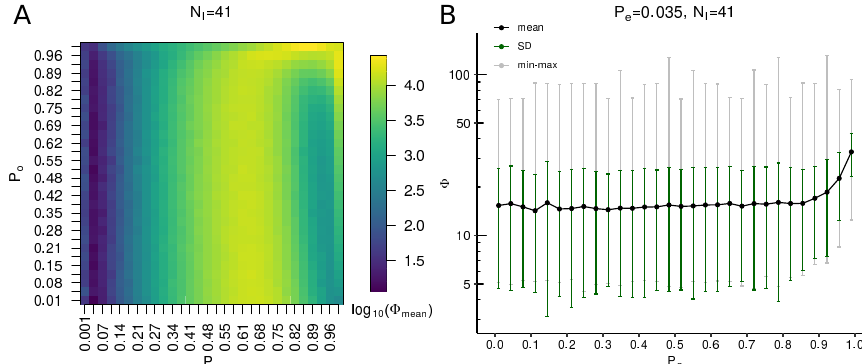
Figure 10. The landscape of topological fitness of rule-based graphs over different values of algorithm ( Φ mean ) values as function of varying parameters P e and P o and fixed parameters. ( A ) Image of log 10 N l = 41. The mean values are calculated in each image cell over 640 graphs realizations of rule-based graphs generated with corresponding parameter sets. ( B ) Dependence of objective function on P o with fixed P e = 0.035, N l = 41. The statistics on values of objective function (14) are calculated over 10,000 realizations of the algorithm for each value of P o